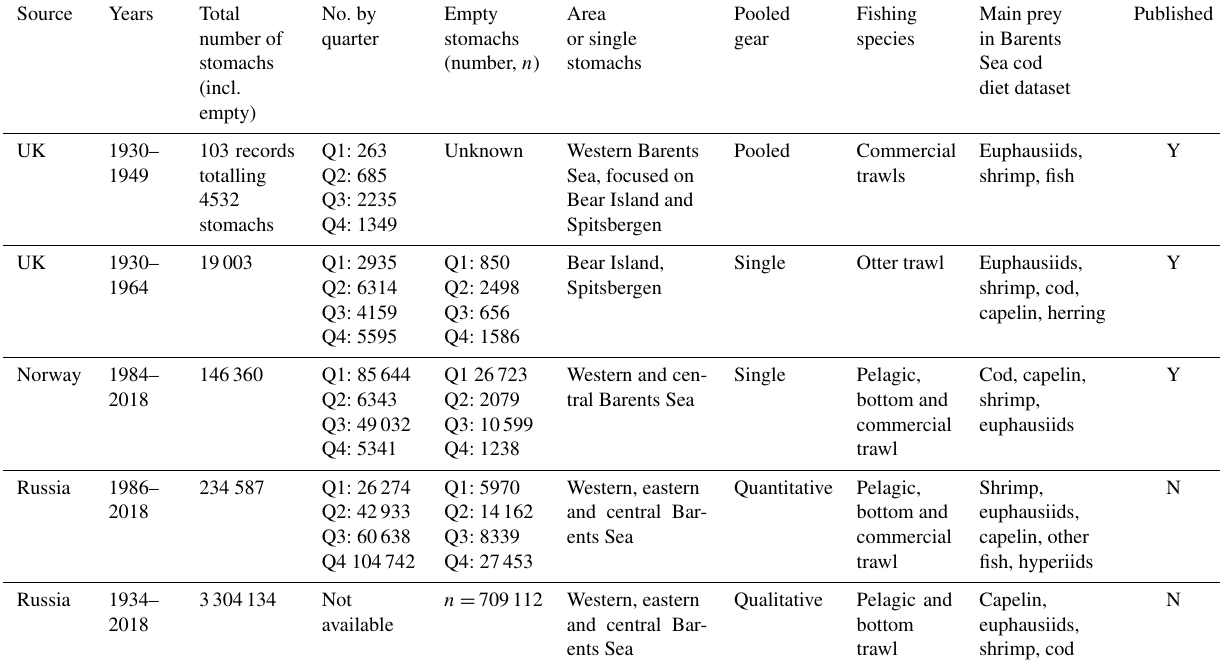
Table 1. The data available on Barents Sea cod stomachs.